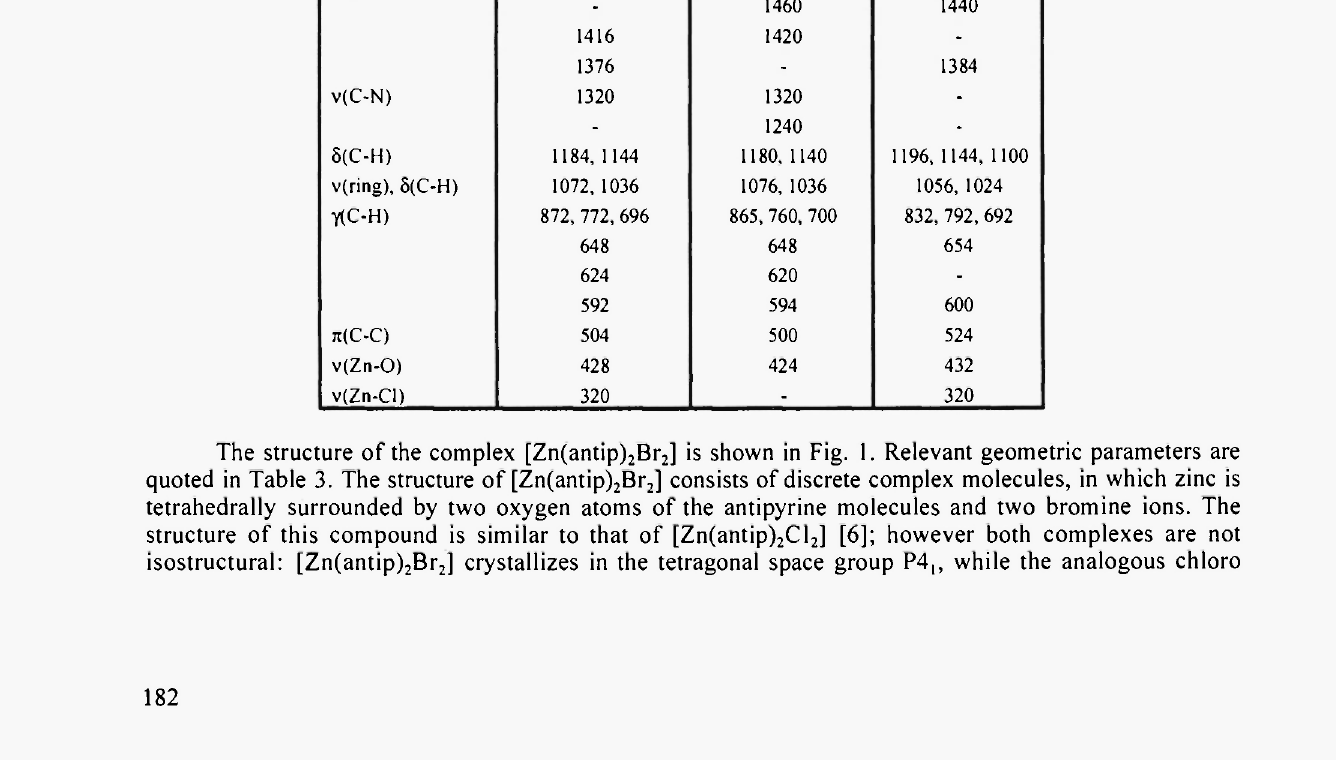
Table 4. Characteristic absorption bands in IR